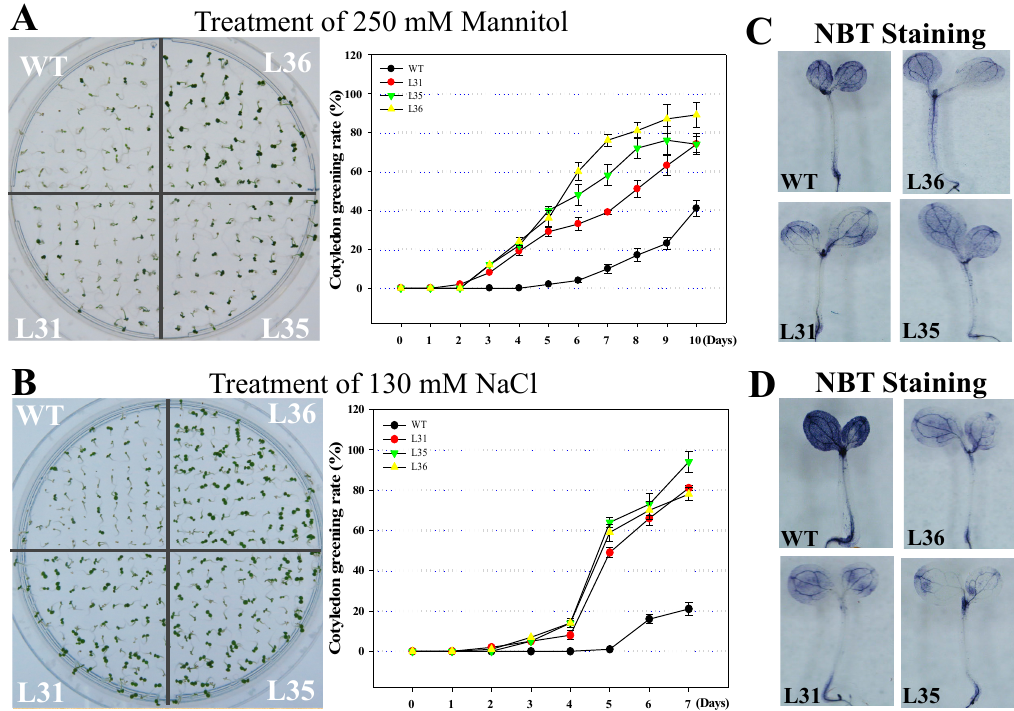
Figure 5. Cotyledon greening rates of VqSTS36 transgenic Arabidopsis lines following the induction of osmotic stress. Homozygous seeds from VqSTS36 transgenic lines (L31, L35, and L36) and untransformed controls (WT) were placed on MS medium added with 250 mM mannitol ( A ) and 130 mM NaCl ( B ), respectively, and assessed for cotyledon greening rates.Cotyledon greening rates were assessed daily following the initiation of each treatment. Representative images of plants were taken 10 days after seeds were plated on an osmotic stress-inducing medium. Data represent mean values from three independent experiments. ( C ) and ( D ) NBT staining for seedlings treated with drought and salt stresses.